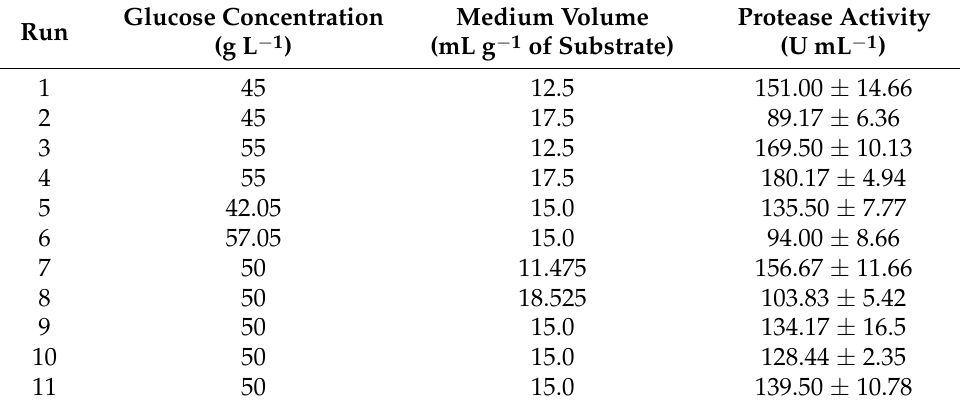
Table 3. Experimental conditions and results of protease production by Aspergillus tamarii URM4634 in sequential fermentations using wheat bran as a substrate. Optimization tests were carried out according to a central composite rotational